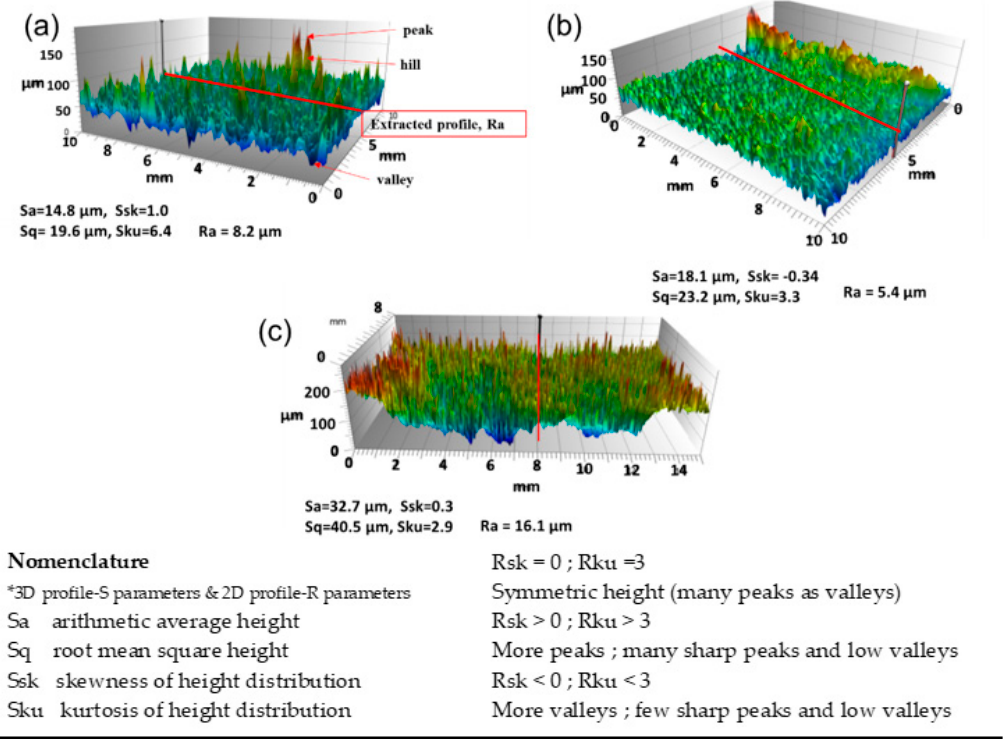
Figure 8. Three-dimensional topographic images and selected surface parameter of the as-sprayed ( a ) HVOF-HEA_Mo27 ( b ) ESD-HEA_Mo27 and ( c ) LC-HEA_Mo27 coatings. ( a ) HVOF-HEA_Mo27 ( b ) ESD-HEA_Mo27 and ( c ) LC-HEA_Mo27